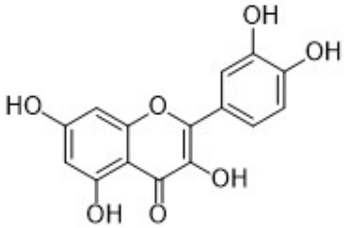
Figure 20. Chemical structure of quercetin (QR).